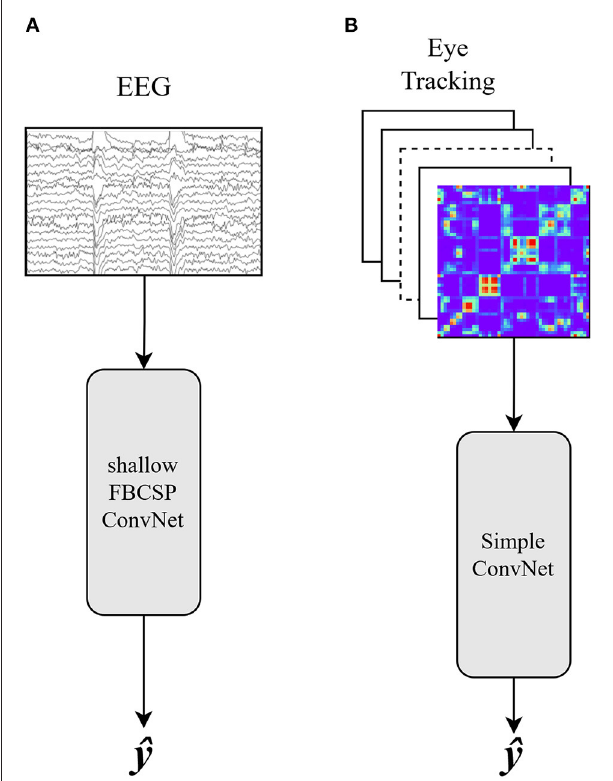
FIGURE 1 | (A) Single modality classification approach for EEG data using the shallow FBCSP Convolutional Neural Network. The preprocessed time-series is used as the input. (B) Single modality classification approach for eye tracking data using a Simple Convolutional Neural Network. The stacked images represent the Markov Transition Fields and Gramian Angular Fields computed on the raw data (see section 2.2). Both: ˆ y is the class prediction.